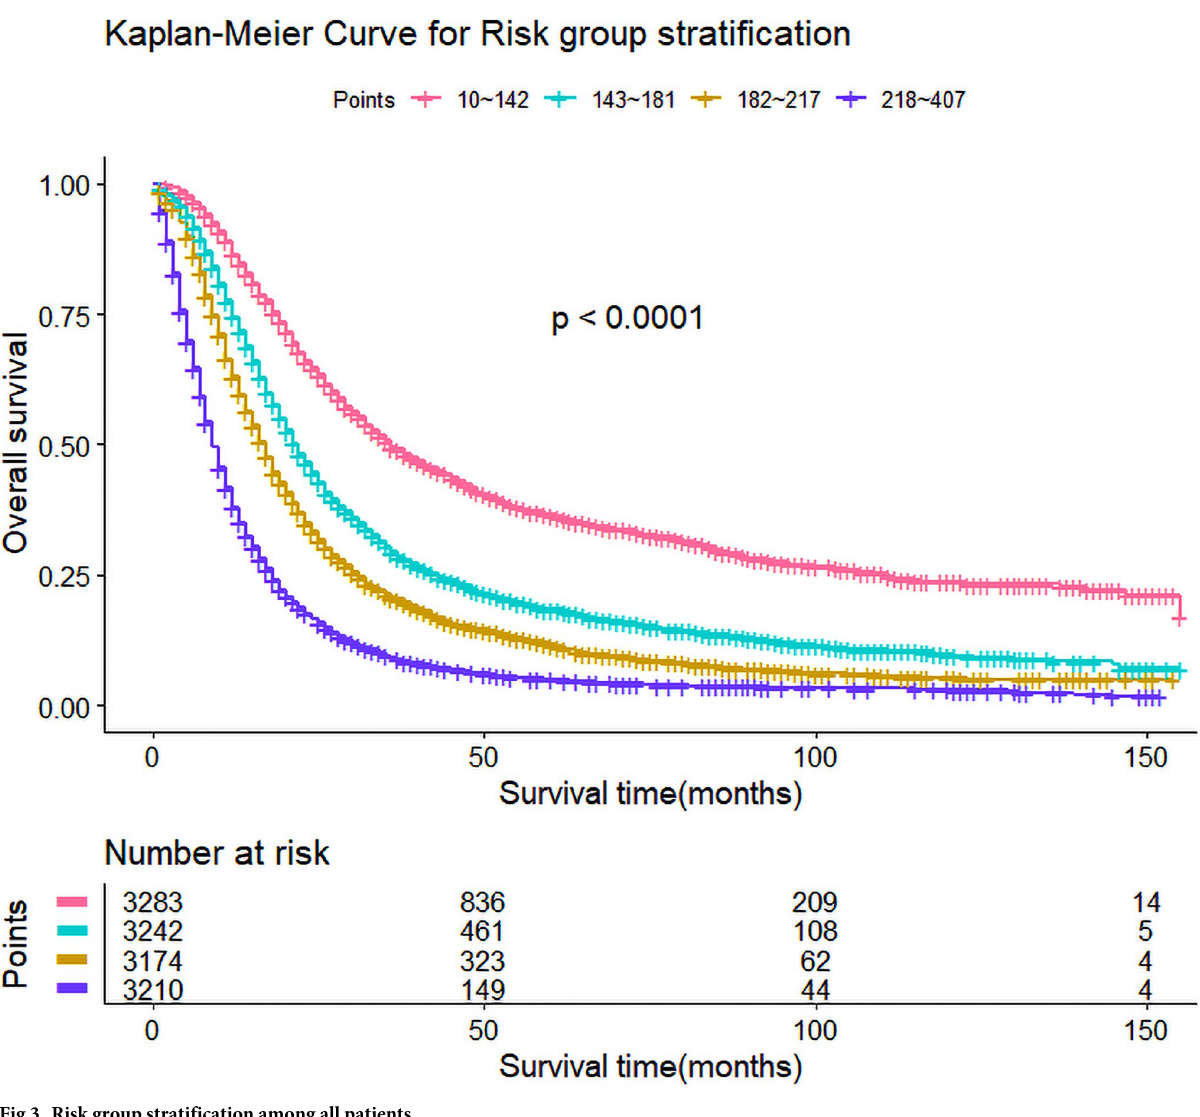
Fig 3. Risk group stratification among all